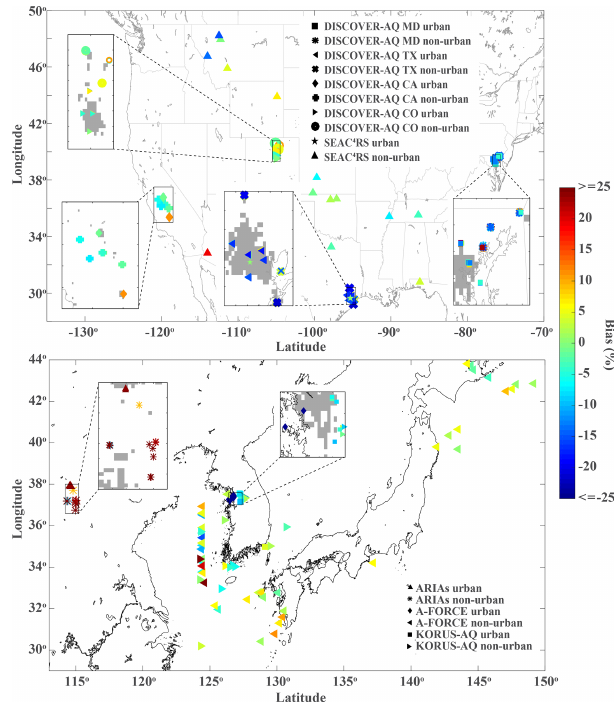
Figure 1. Spatial distributions of aircraft profiles from the DISCOVER-AQ, SEAC 4 RS, ARIAs, A-FORCE, and KORUS-AQ campaigns. Urban and built-up land cover (from MCD12C1 v006) are shown by gray shade in the boxes. Biases of MOPITT V8J com- pared to the aircraft profile at the surface layer are shown by the color of the